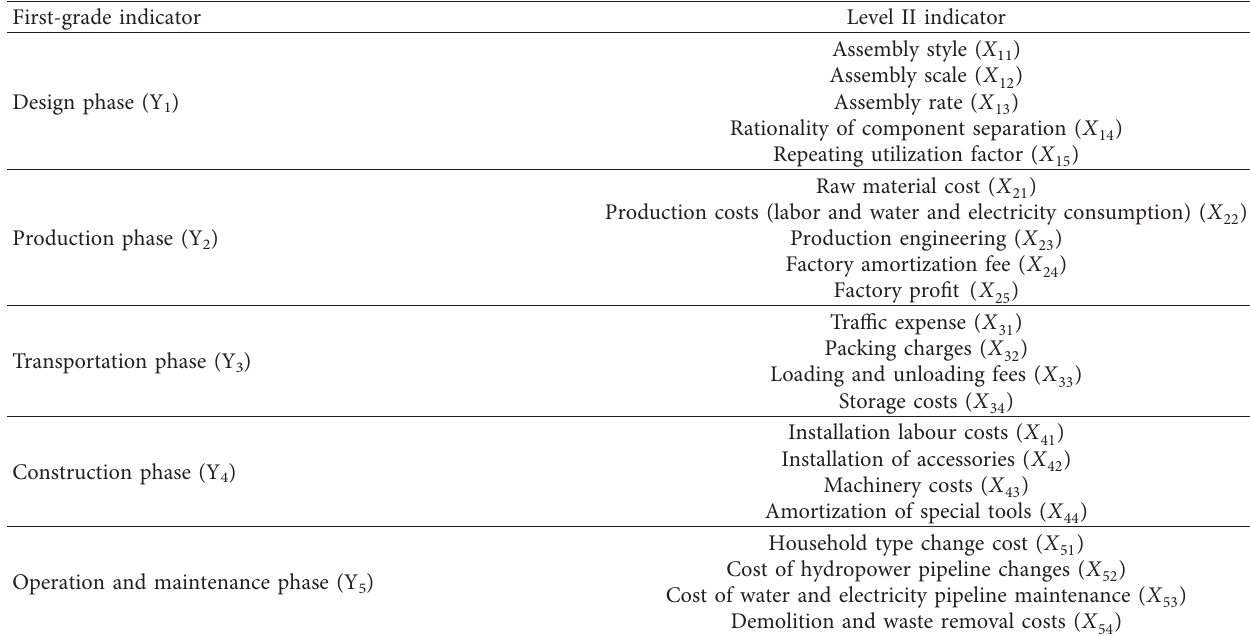
Table 3: Factors affecting the cost of prefabricated decoration.